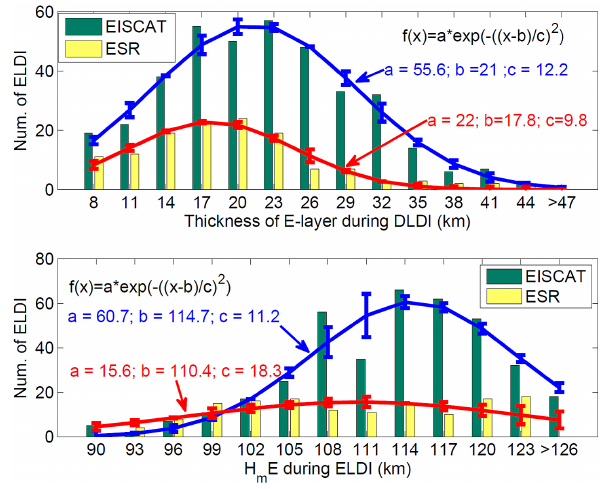
Figure 5. Distribution of ELDI with E layer thickness (the top panel) and H m E (the bottom panel). Gaussian fitting lines of the distributions are also superposed, with residuals as error bars.